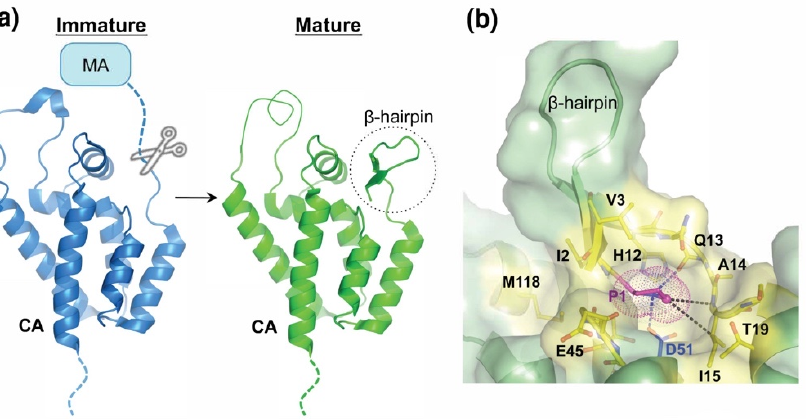
Figure 2. Proteolytic Processing at the HIV-1 MA-CA Junction Refolds the HIV-1 CA N-terminus into a β -hairpin Conformation that Buries the N-terminal CA Pro 1 Residue. ( a ) Proteolytic processing (scissors) of the immature Gag polyprotein at the MA–CA junction of the Gag 1-278 polyprotein (blue, PDB: 2GOL) creates a new CA N-terminus and drives folding of the N-terminal CA β -hairpin (dashed circle, green, PDB: 2GON). ( b ) The mature N-terminal CA Pro1 (P1) fits snugly into a pocket in which the buried, protonated N-terminus makes a salt bridge with Asp51 and a hydrogen bond with Gln13 (blue dashed lines), and Pro1 C δ makes hydrophobic packing interactions with Ala14 and Ile15 (black dashed lines, PDB: 4B4N).